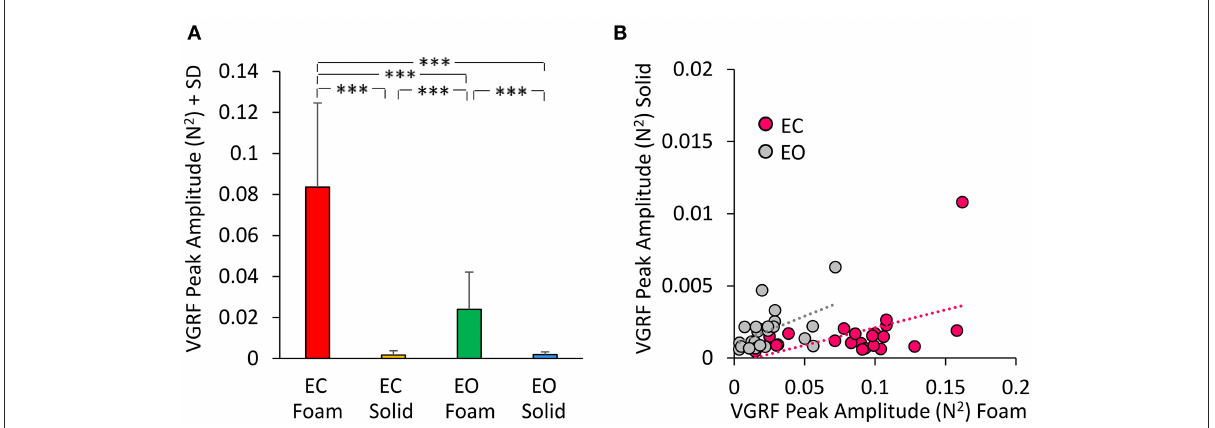
FIGURE5 VGRF Peak amplitude. The mean VGRF Peak amplitude (A) are reported for each vision and support condition. Amplitude was the greatest in EC Foam condition and decreased with EO Foam. It was the smallest with Solid support, where vision had no effect. (B) The VGRF amplitudes for Solid are plotted against those for Foam, for each subject and vision condition (EC, pink dots; EO, gray dots). The equations of the lines fitting the Solid vs. Foam data points were: EC, y = 0.024 x- 0.0003 (R 2 = 0.23, p < 0.05); EO, y = 0.039 x + 0.001 (R 2 = 0.26, p < 0.05). Asterisks indicate significant differences (*** p < 0.001).